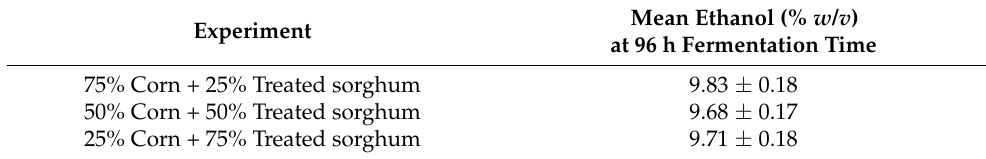
Table 3. Ethanol generated by corn and sorghum mixtures, no cellulase.